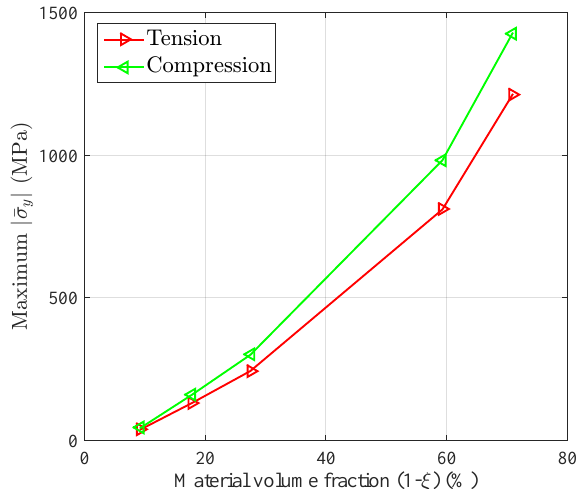
Figure 5. The relation between the stiffness and the material volume fraction (1- ξ ) of the RVE when the absolute value of strain is up to 10%.